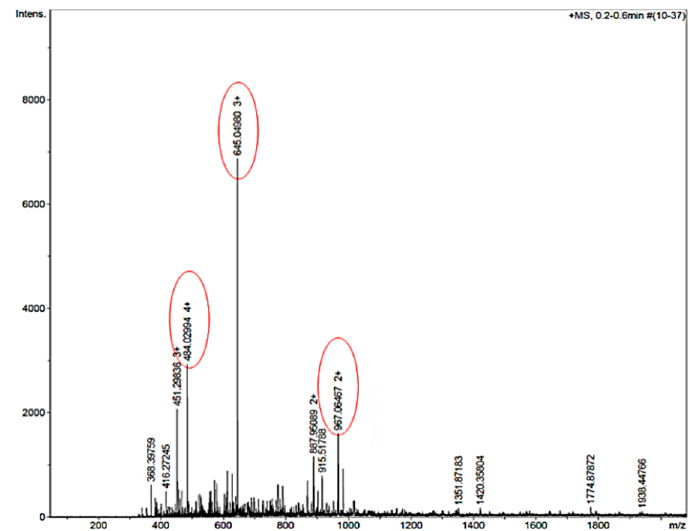
Figure 2. Mass spectra of AEP-K-FP shows the dominant peak (645 with triple positive charge) of intensity 6.9 × 10 3 refers to the theoretical MW (m / z = (1932 + 1.008 × 3) / 3). Alternatively, the peaks 484 with quaternary charge at 3 × 10 3 intensity and 967 with double charge at 1.7 × 10 3 intensity represent the related ions of AEP-K-FP (m / z = (1932 + 1.008 × 4) / 4 and m / z = (1932 + 1.008 × 2) / 2, respectively.